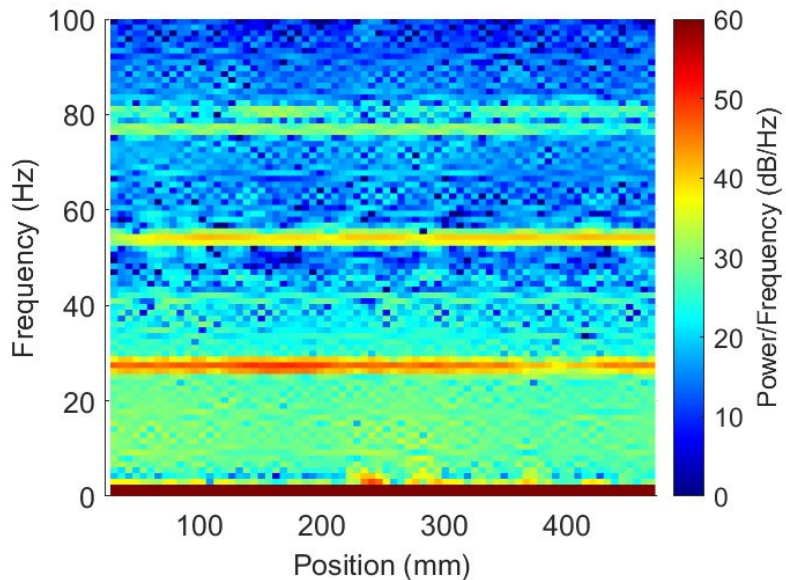
Figure 8. A spectral map from weld 6c ranging from 0 to 100 Hz along the length of a weld. Z axis force was used in the PSD calculations for this plot from the weld depicted in Figure 2.